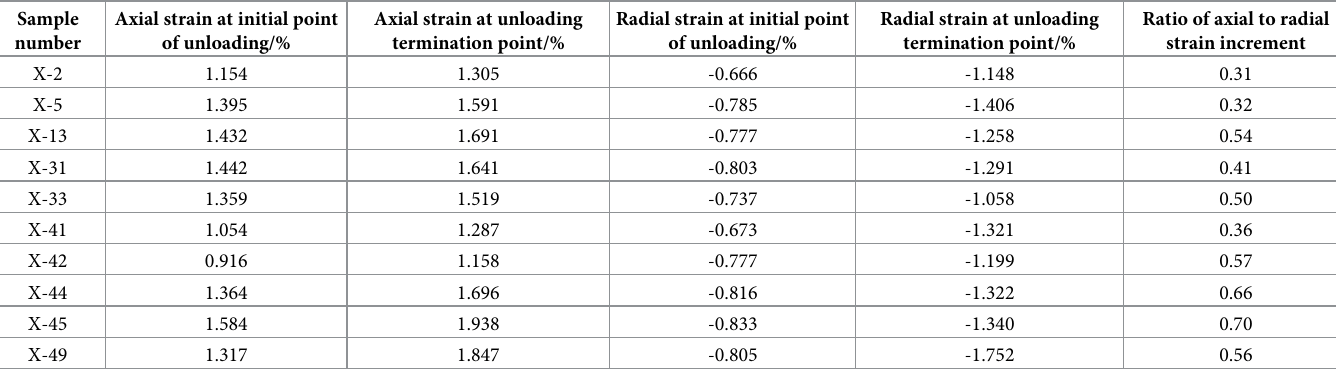
Table 4. The ratio of the change of axial strain to radial strain in unloading tests.